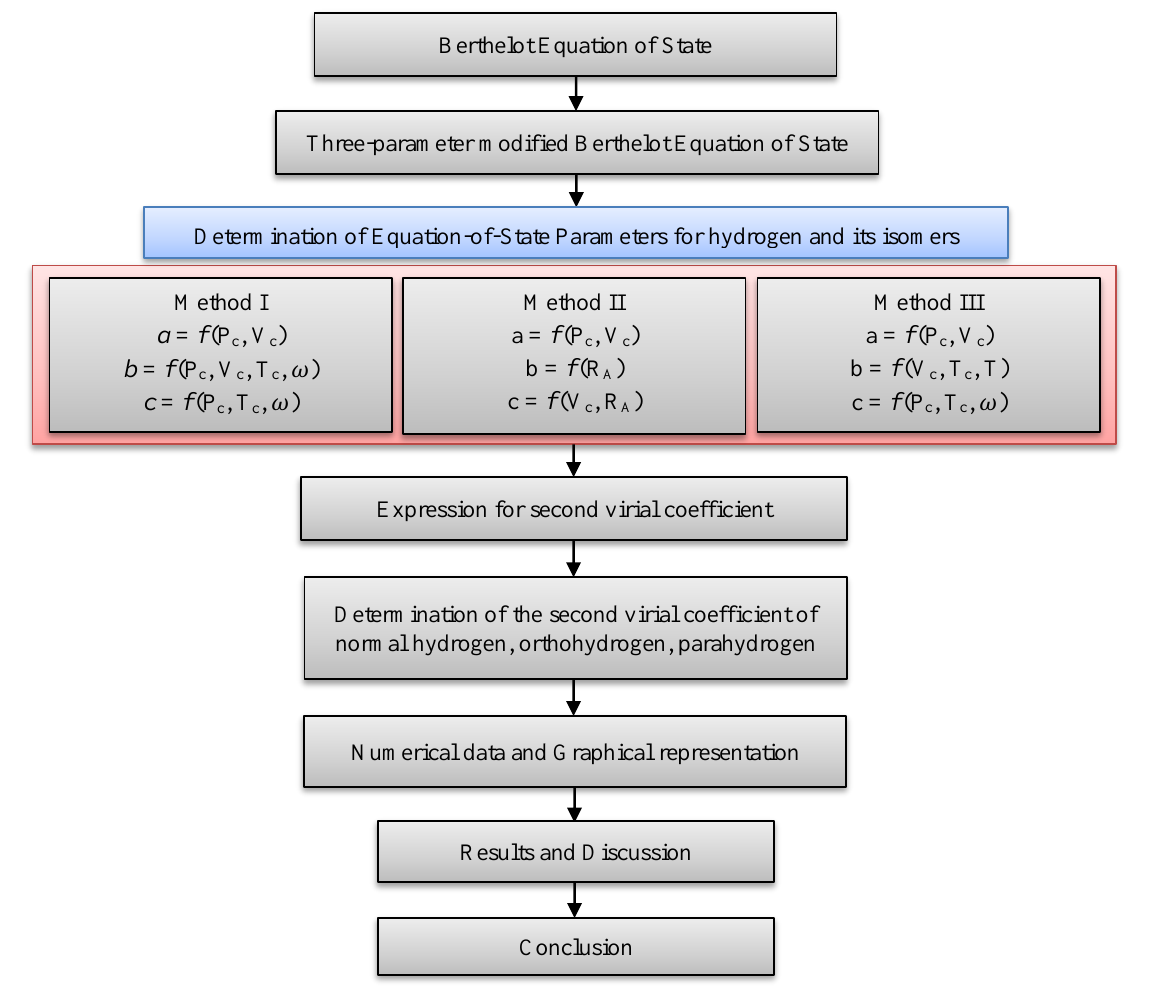
Figure 1. Flowchart of the research methodology